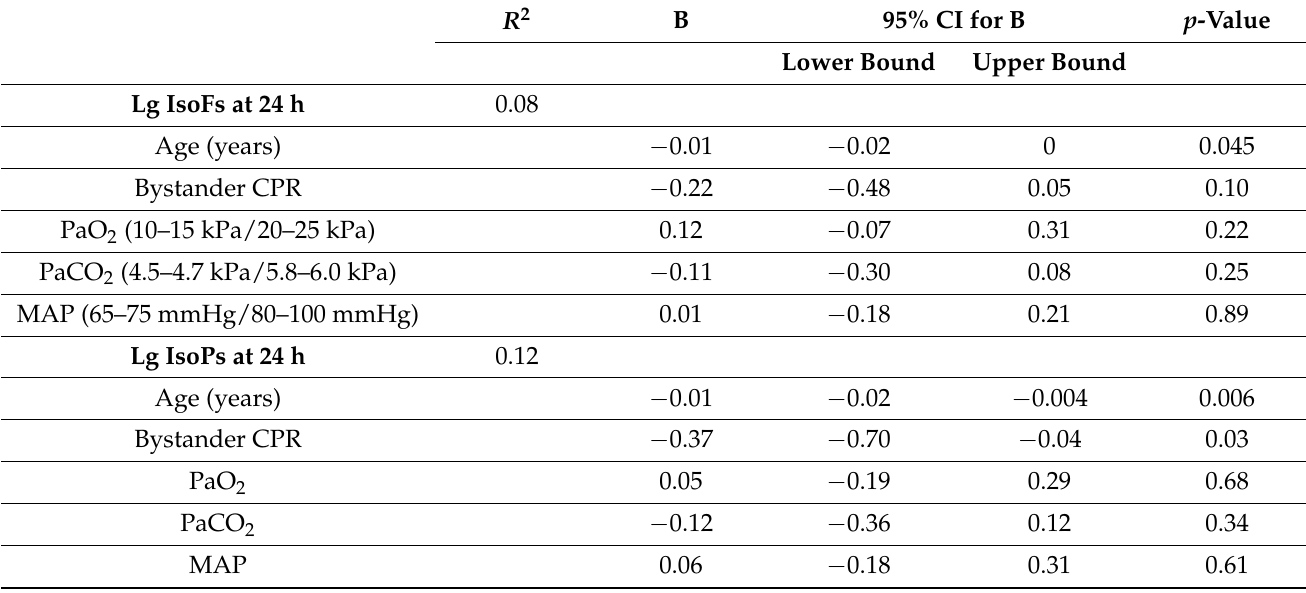
Figure 3. Median biomarker levels on ICU admission and 24, 48, and 72 h after admission. The midline of the box represents the median; the upper and lower borders of the box represent the interquartile range. The whiskers are at the minimum and maximum values. Note the logarithmic scale on the y-axis. The p -value indicates the significance of the biomarker level change over time between the low vs. high PaO 2 treatment target groups determined with linear mixed model analysis. Definitions of abbreviations: [p.d.u] = procedure defined unit. Table 2. Linear regression analysis to predict biomarker levels at 24